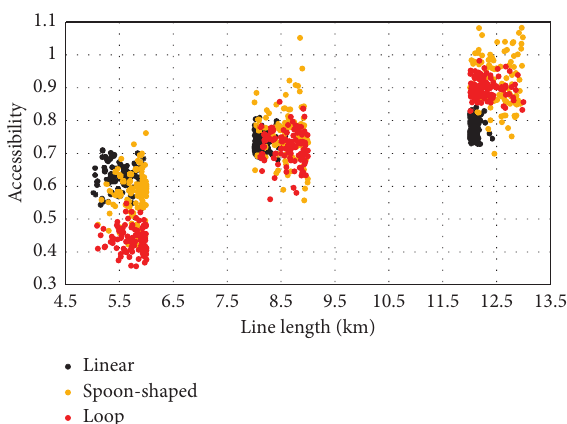
Figure 11: The scatter plot of all optimal solutions under three conditions.